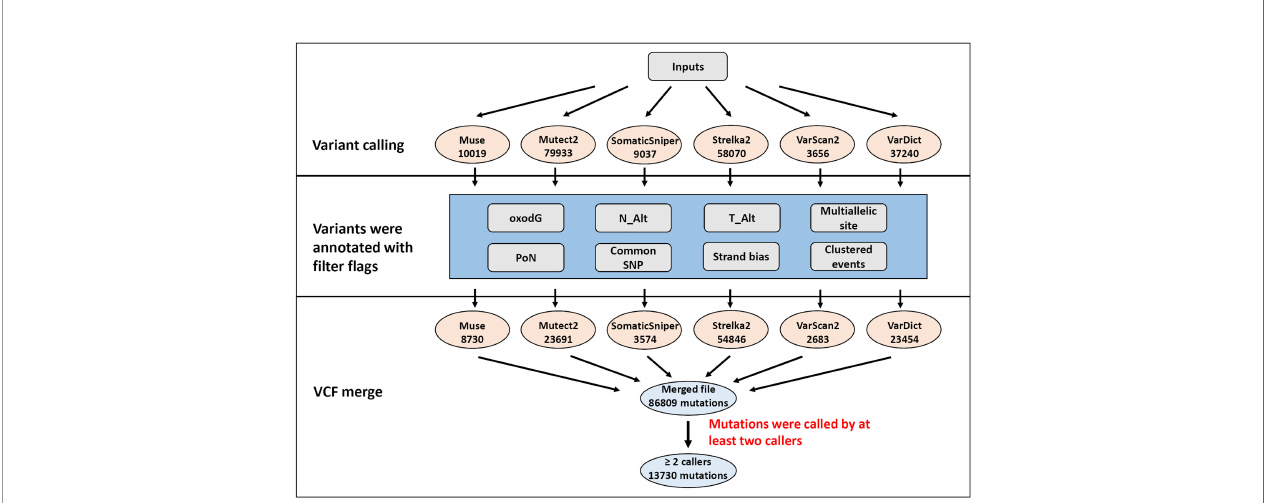
FIGURE 1 | Flowchart of the fi ltering strategy. Mutations were identi fi ed by multiple variant callers parametrized to identify potentially somatic mutations. The number of mutations for each fi ltering step is depicted in